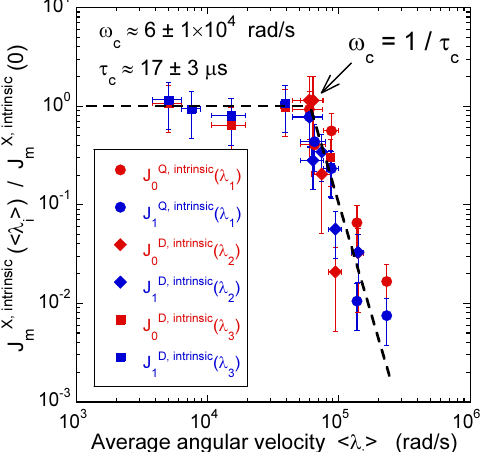
Figure 10. Variation of the intrinsic spectral densities J Q , intr m ( λ 1 ) with m ∈ { 0,1 } , describing quadrupolar coupling, and J D , intr m ( λ i ) with m ∈ { 0,1 } and i ∈ { 2,3 } , describing the heteronuclear dipolar coupling, as a function of the corresponding averaged angular velocities < λ i > ( 2 H NMR). Reprinted with permission from [23]. Copyright (2014) American Chemical